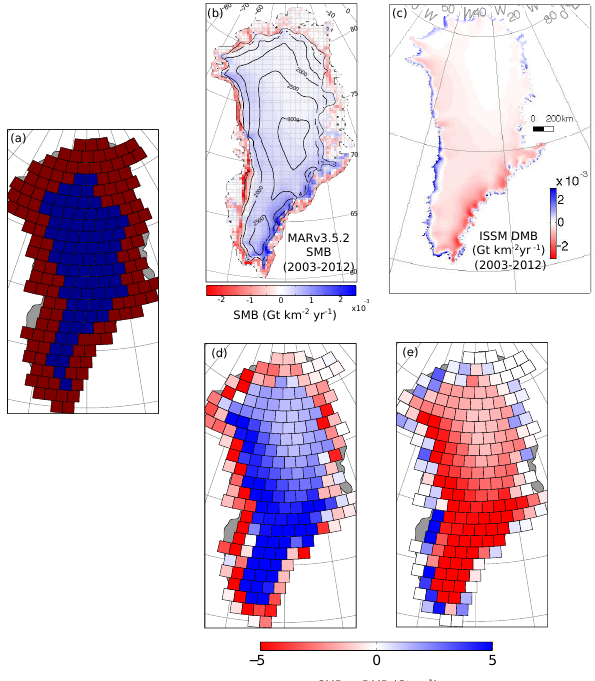
Figure 1. (a) Grid of mascons over the GrIS and constraint re- gions for the GRACE solution of Luthcke et al. (2013). Areas below 2000m in elevation are red, while areas above 2000m are blue. (b) MAR v3.5.2 average specific surface mass balance (SMB,Gtkm − 2 yr − 1 ) for January 2003–December 2012 on the MAR grid, for the GrIS and periphery (contours show elevation above sea level). (c) ISSM average specific dynamic mass balance (DMB,Gtkm − 2 yr − 1 ) for the same period on the ISSM mesh. SMB and DMB for the 2003–2012 period aggregated to the GRACE-LM grid (without filtering) are also shown for MAR v3.5.2 (d) and ISSM (e)